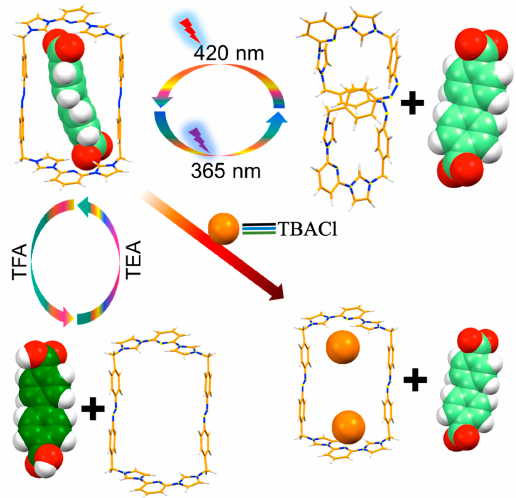
Figure 3. Cartoon representation of the multi-responsive capture-and-release of guest by TxSB 5 , including photo-, pH-, and anion-responsiveness. Reproduced from ref [44]. Copyright 2019 American Chemical Society.